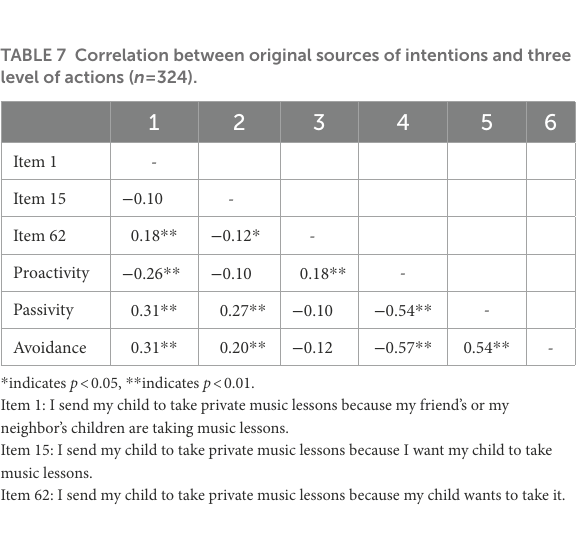
TABLE 8 ANOVA results of three level of actions ( n = 324).